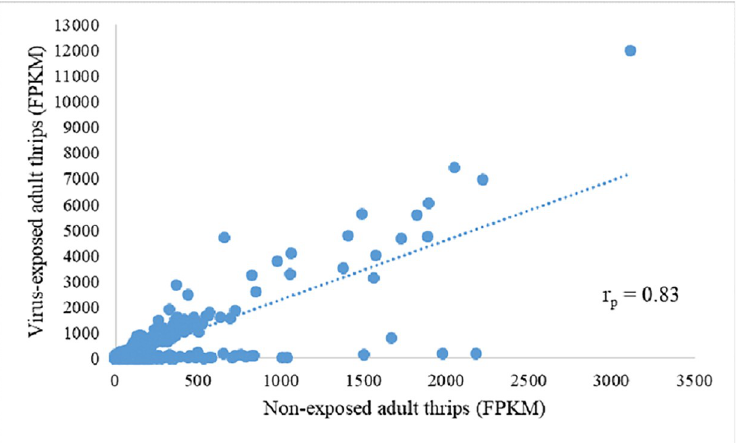
Fig 1. Comparison of normalized read counts (FPKM) between CaCV-exposed and non-exposed adults of Thrips palmi . Each point represents one transcript with log 2 fold change > 1 in relative abundance between the two treatments and a q-value < 0.01. r p = Pearson’s correlation coefficient.